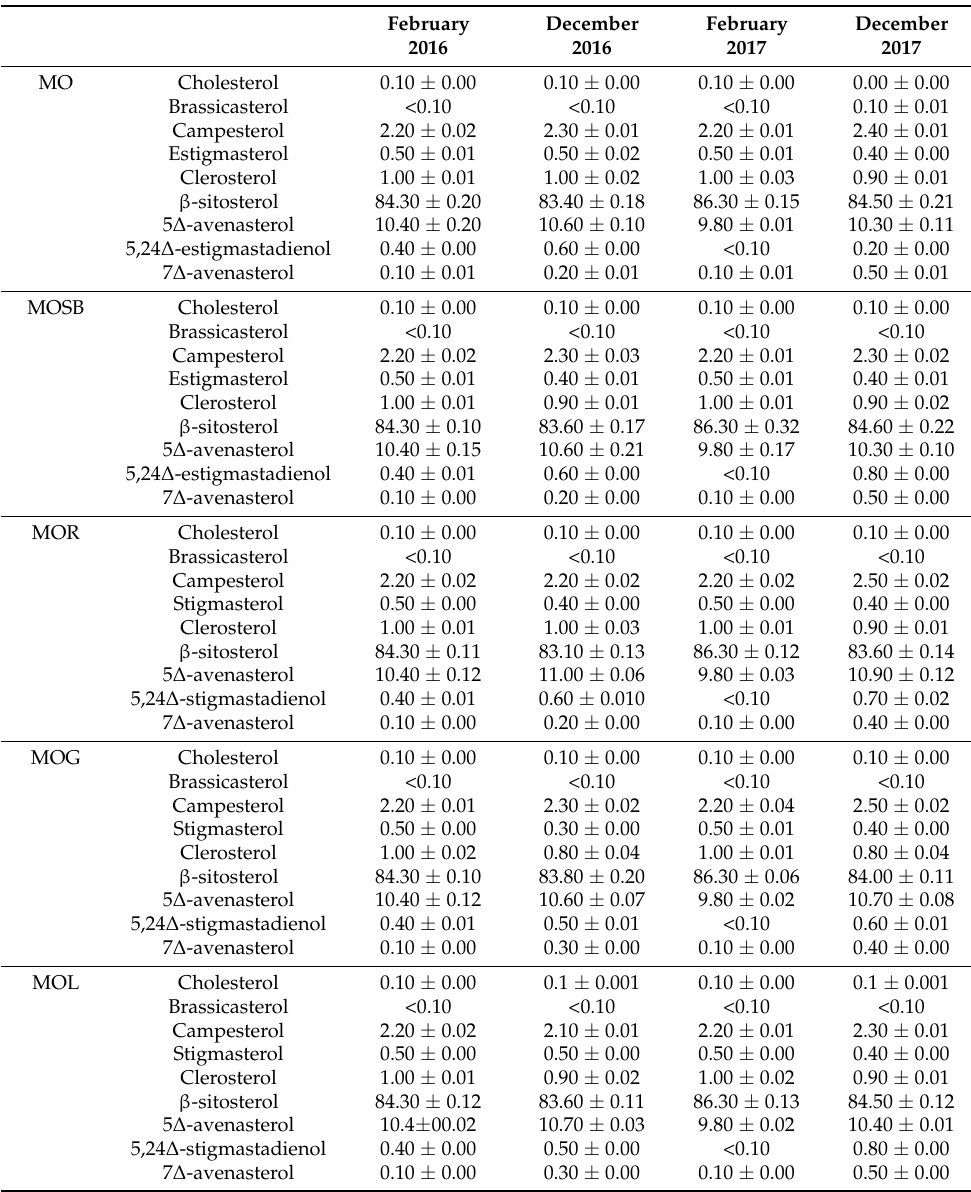
Table 8. Individual sterols (%) of all olive oils.